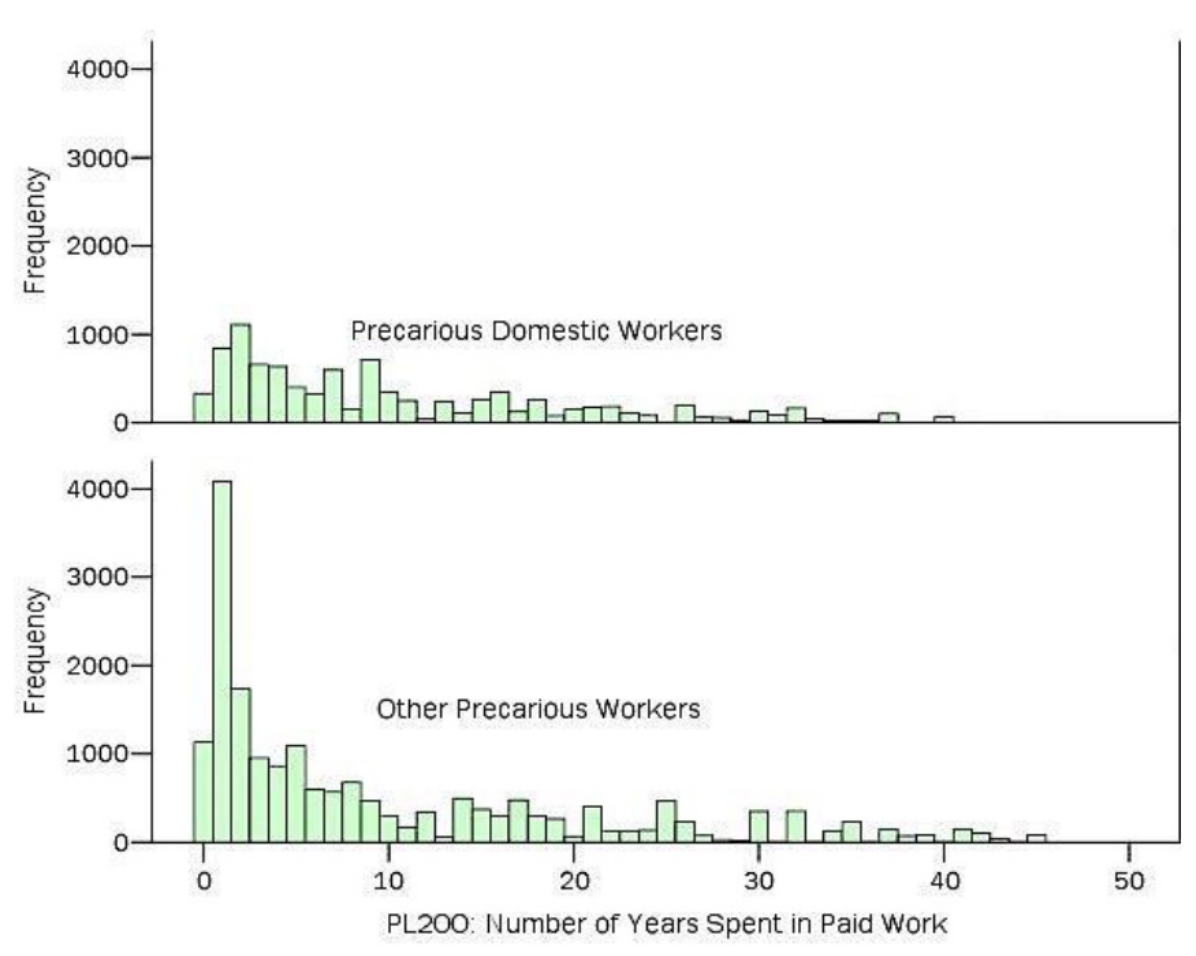
Figure 9. Distribution of precarious Domestic Workers by duration of professional experience (2019). Data source: Eurostat EU-SILC (2020).